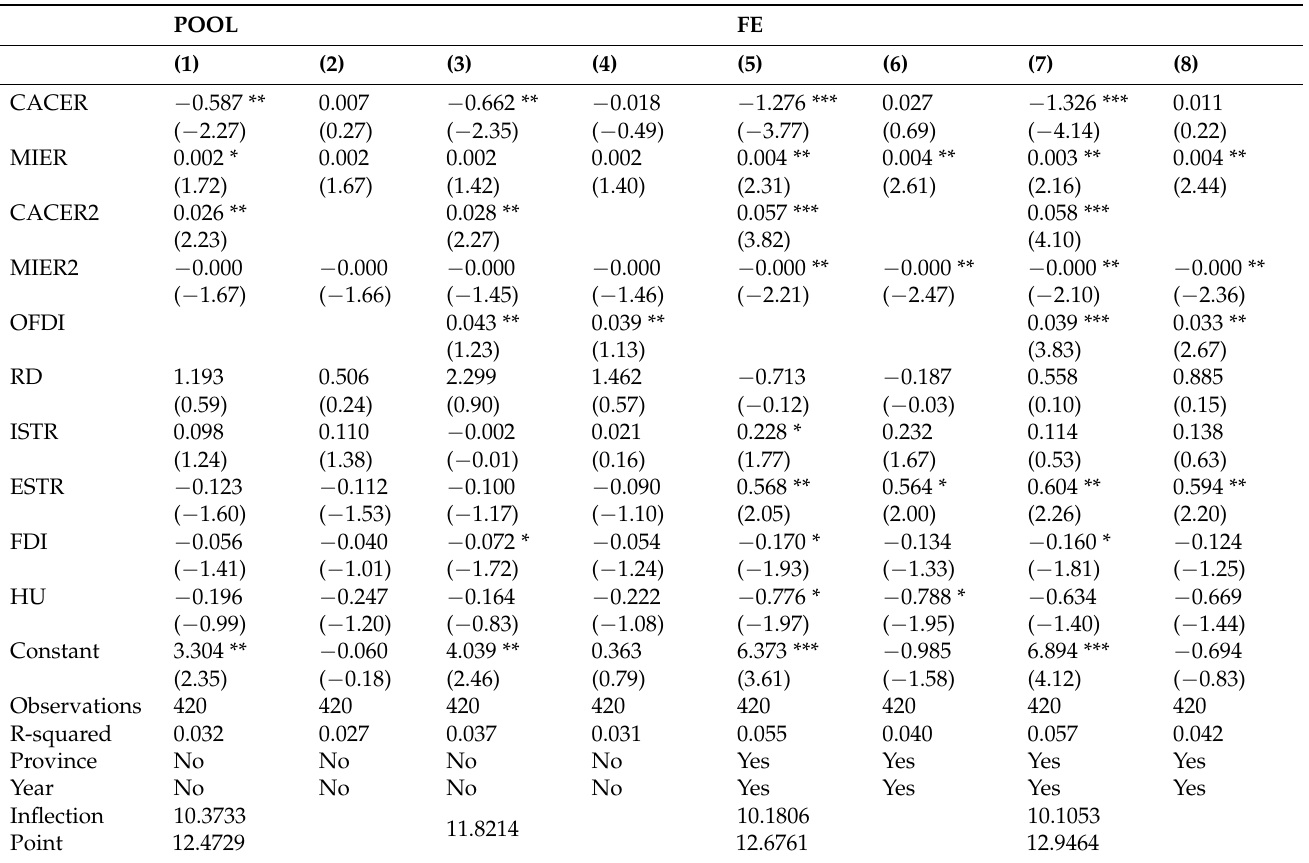
Table 8. Estimated results of the impact of ERs and OFDI on